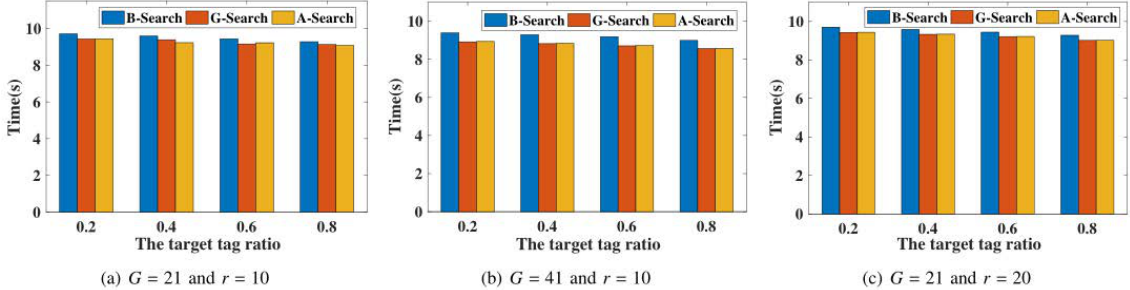
Figure 7. The time efficiency of each protocol under target tag ratios.